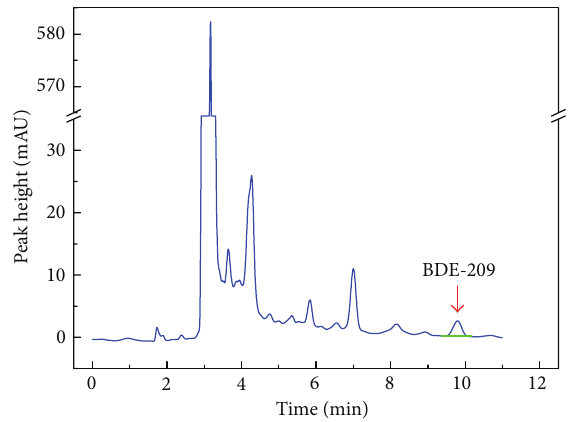
Figure 4: The peak of BDE-209 in QBS.